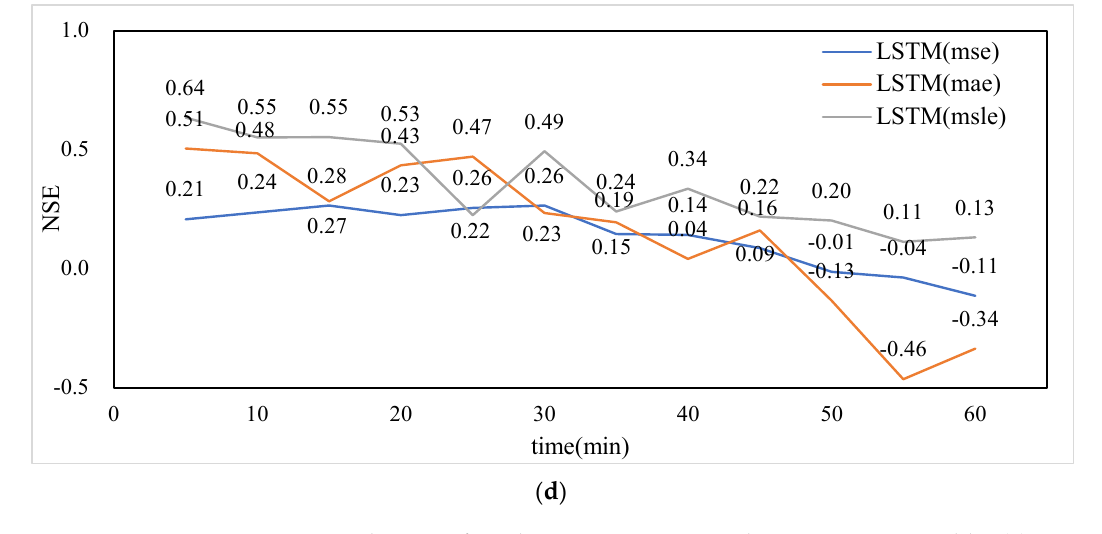
Figure 4. Evaluation of prediction accuracy at each moment measured by ( a ) RMSE, ( b ) MAE, ( c ) MAPE and ( d ) NSE.